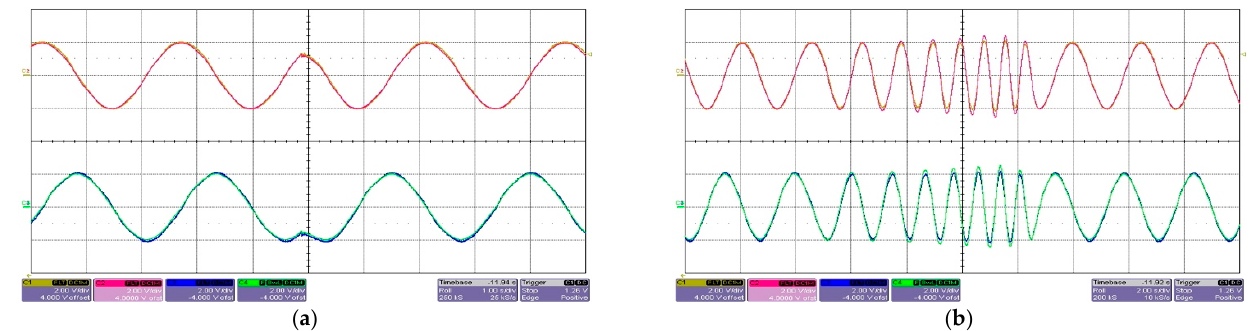
Figure 12. Experimental results: current sensorless control using estimated stator currents when all current sensors fail. Measured (yellow) and estimated (red) α -component of stator current vector (a-phase stator current), measured (blue) and estimated (green) β -component of stator current vector; ( a ) speed reversal to 10 rpm, ( b ) step changes of load torque from 0 to 2 Nm at 10 rpm. Scales: currents—2 A/div; time—1 s/div ( a ), 2 s/div ( b ).